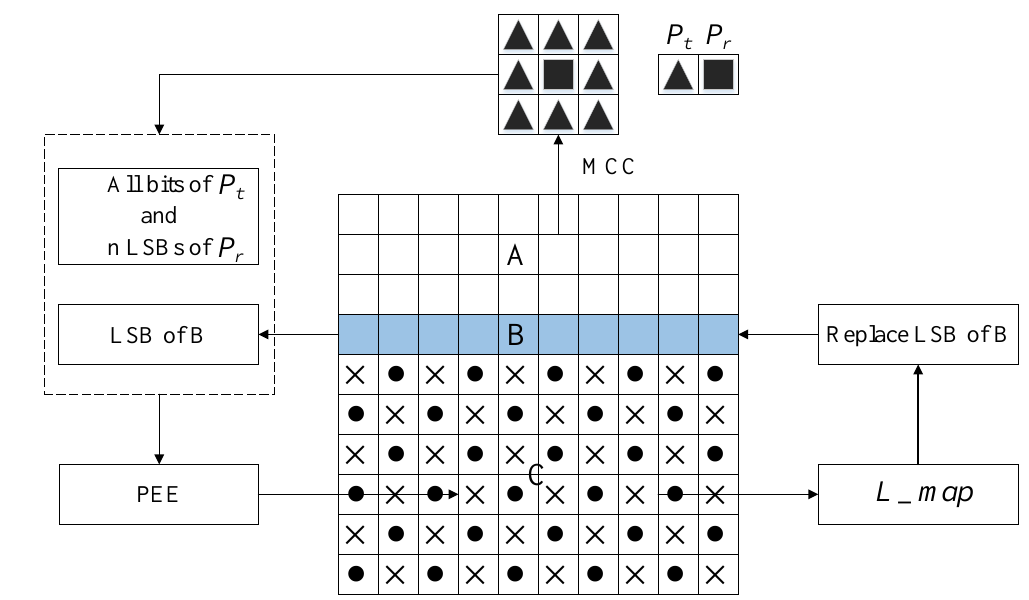
Figure 4. Image partition and self-reversible